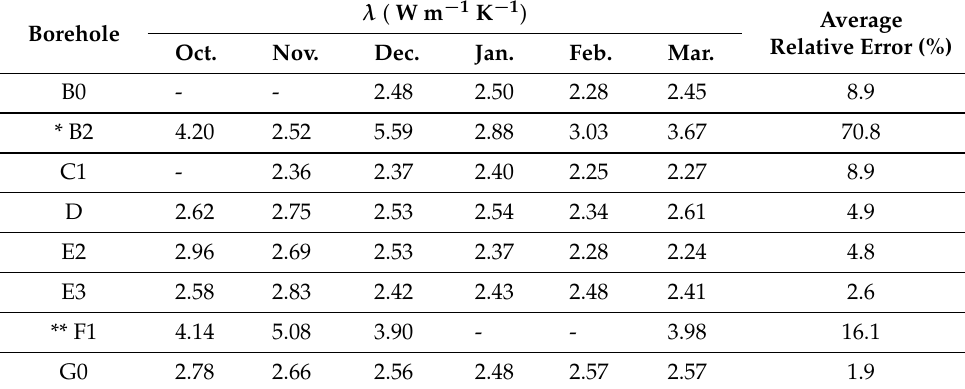
Table 5. Effective thermal conductivity of the ground below 60 m depth for each borehole in each month of the measurement obtained with Equation (2). The mean and the standard deviation of the values in each borehole are included. ( ∗ Less than 10 m of log was used, ∗∗ Damaged grouting). Borehole